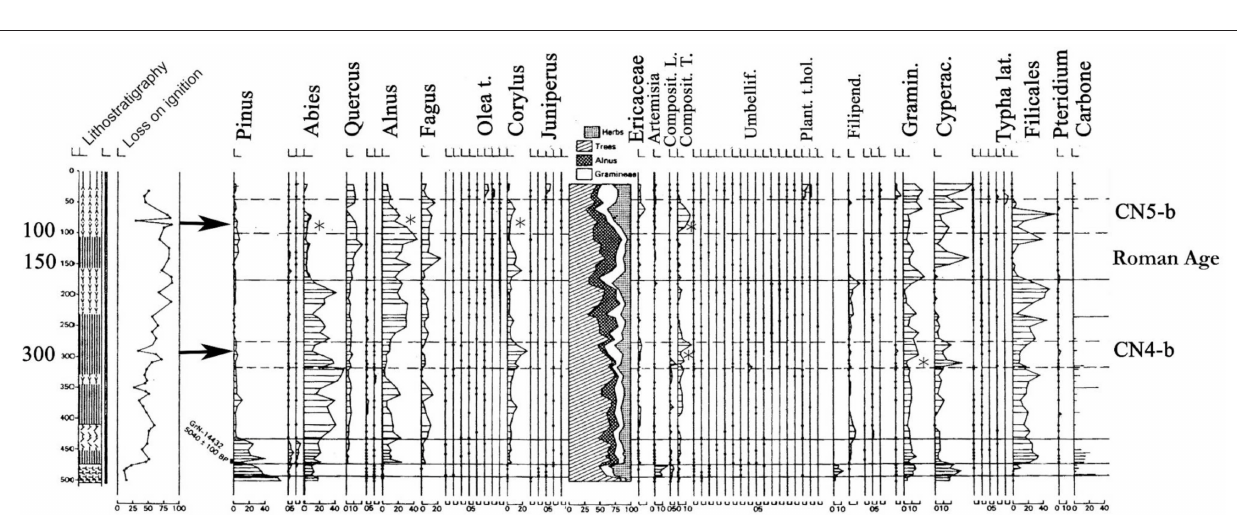
FIGURE 4 | “Mogge di Casanova” pollen diagram (in Cevasco, 2007, p. 154 modified from Cruise, 1990). CN5b corresponds to Middle ages. Signaled by “ ∗ ” some interesting peaks of percentages